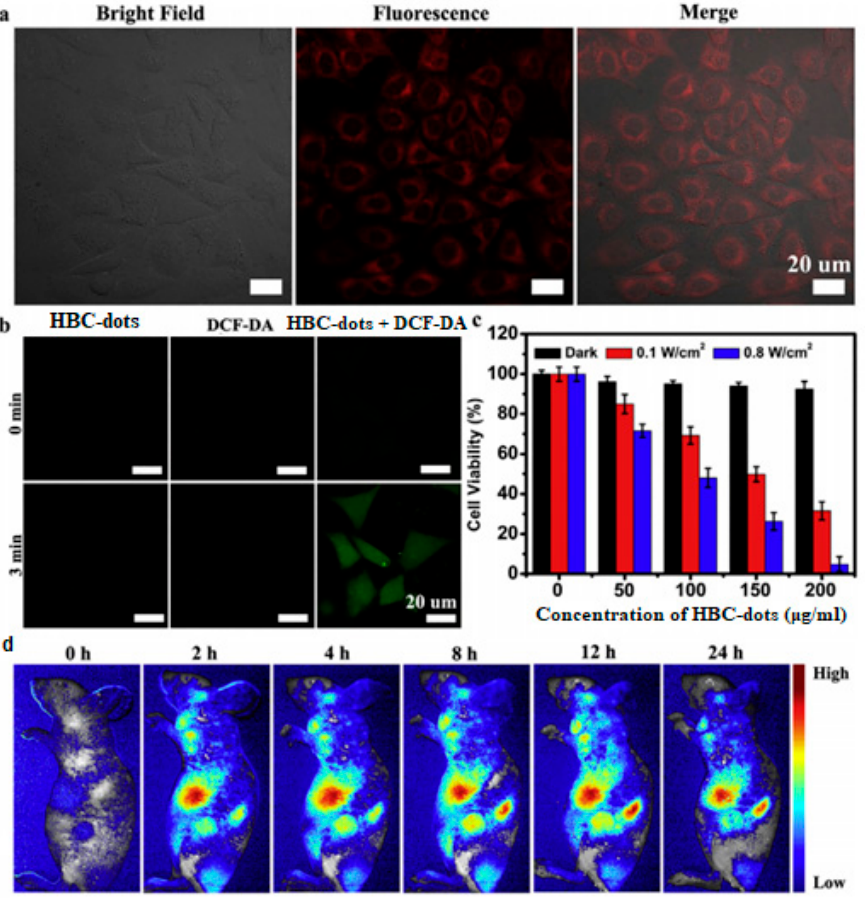
Figure 11. ( a ) FL images of HeLa cells incubated with HBC-dots. ( b ) FL imaging of HeLa cells stained with HBC-dots, DCF-DA and their combination. ( c ) Viability of HeLa cells incubated with HBC-dots after several treatments. ( d ) In vivo FL images of mice after intravenous injection of HBC-dots in PBS. Reprinted (adapted) with permission from [76]. Copyright 2021 Elsevier.